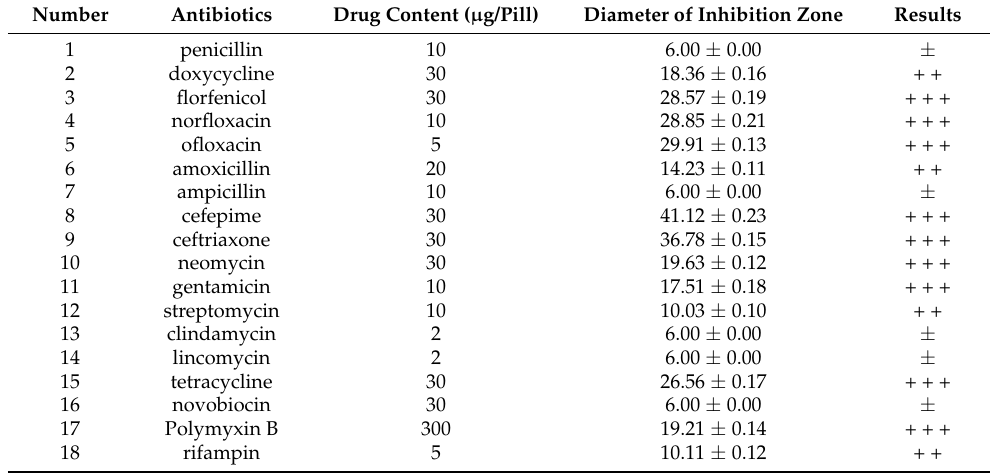
Table 5. Antimicrobialsusceptibilityanalysisof C.freundii isolatesfrom M.rosenbergii